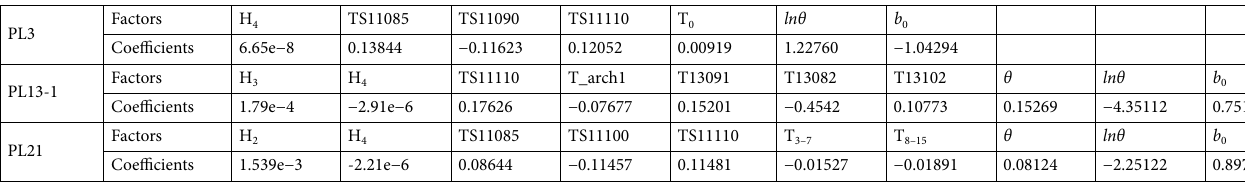
Table 1. Optimal factors and the coefficients of MLSR